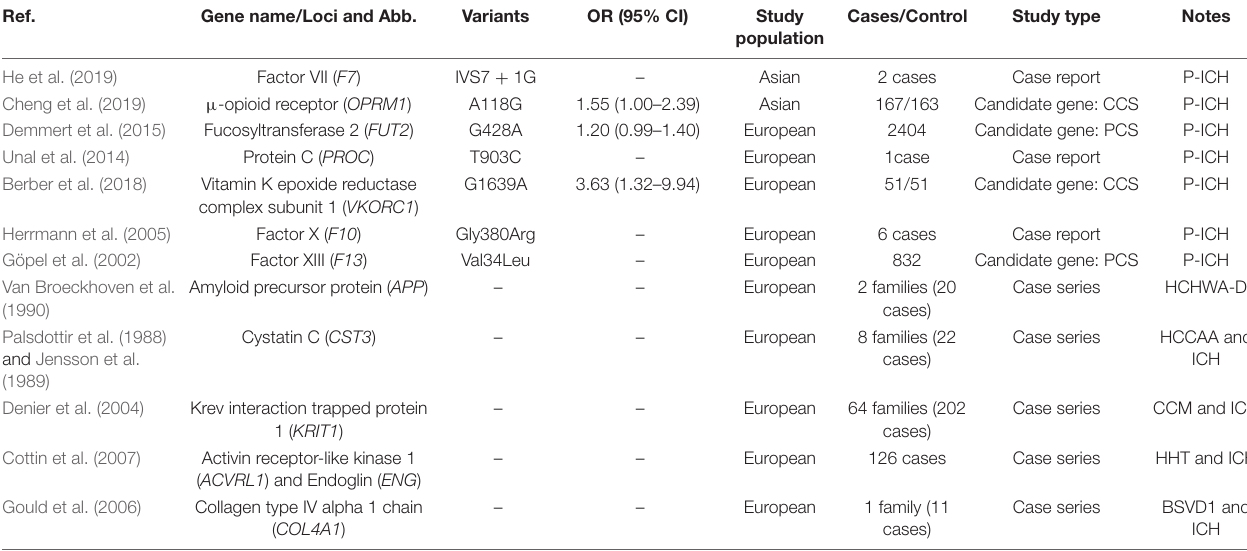
TABLE 5 | Genetics variants/genes related to perinatal and pediatric ICH and ICH of Mendelian forms.